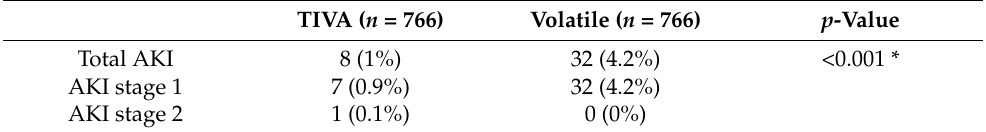
Table 2. Comparison incidence of acute kidney injury (AKI) between total intravenous anesthesia (TIVA) group and volatile anesthesia group for propensity score matched